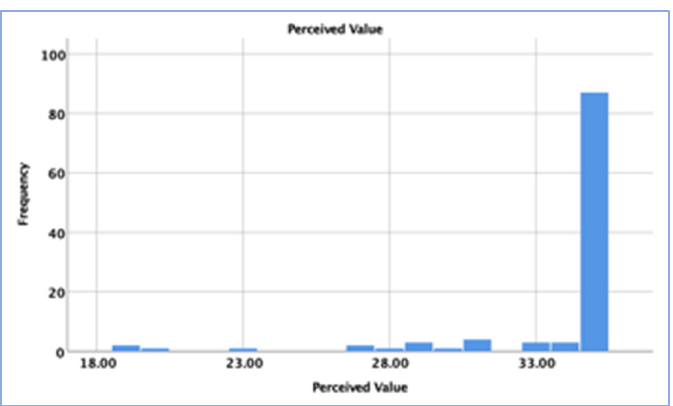
Figure 3. Distribution of Perceived Value